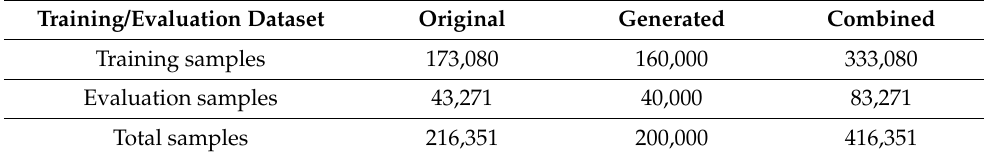
Table 4. Training, evaluation, and total samples of original, generated and combined dataset.